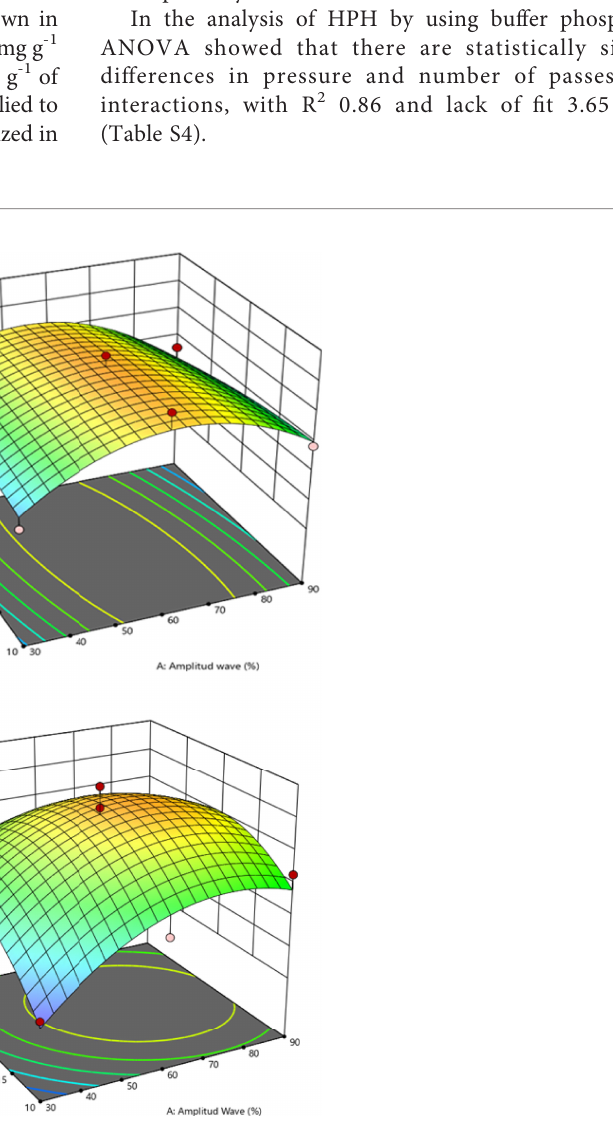
FIGURE 2 | Response surface (3D) plots to display the effect between the amplitude wave (X 1 ) and ultrasonic time (X 2 ) by solvent extraction on the extraction yield: (A) effect between X 1 and X 2 under buffer phosphate, (B) effect between X 1 and X 2 under distilled